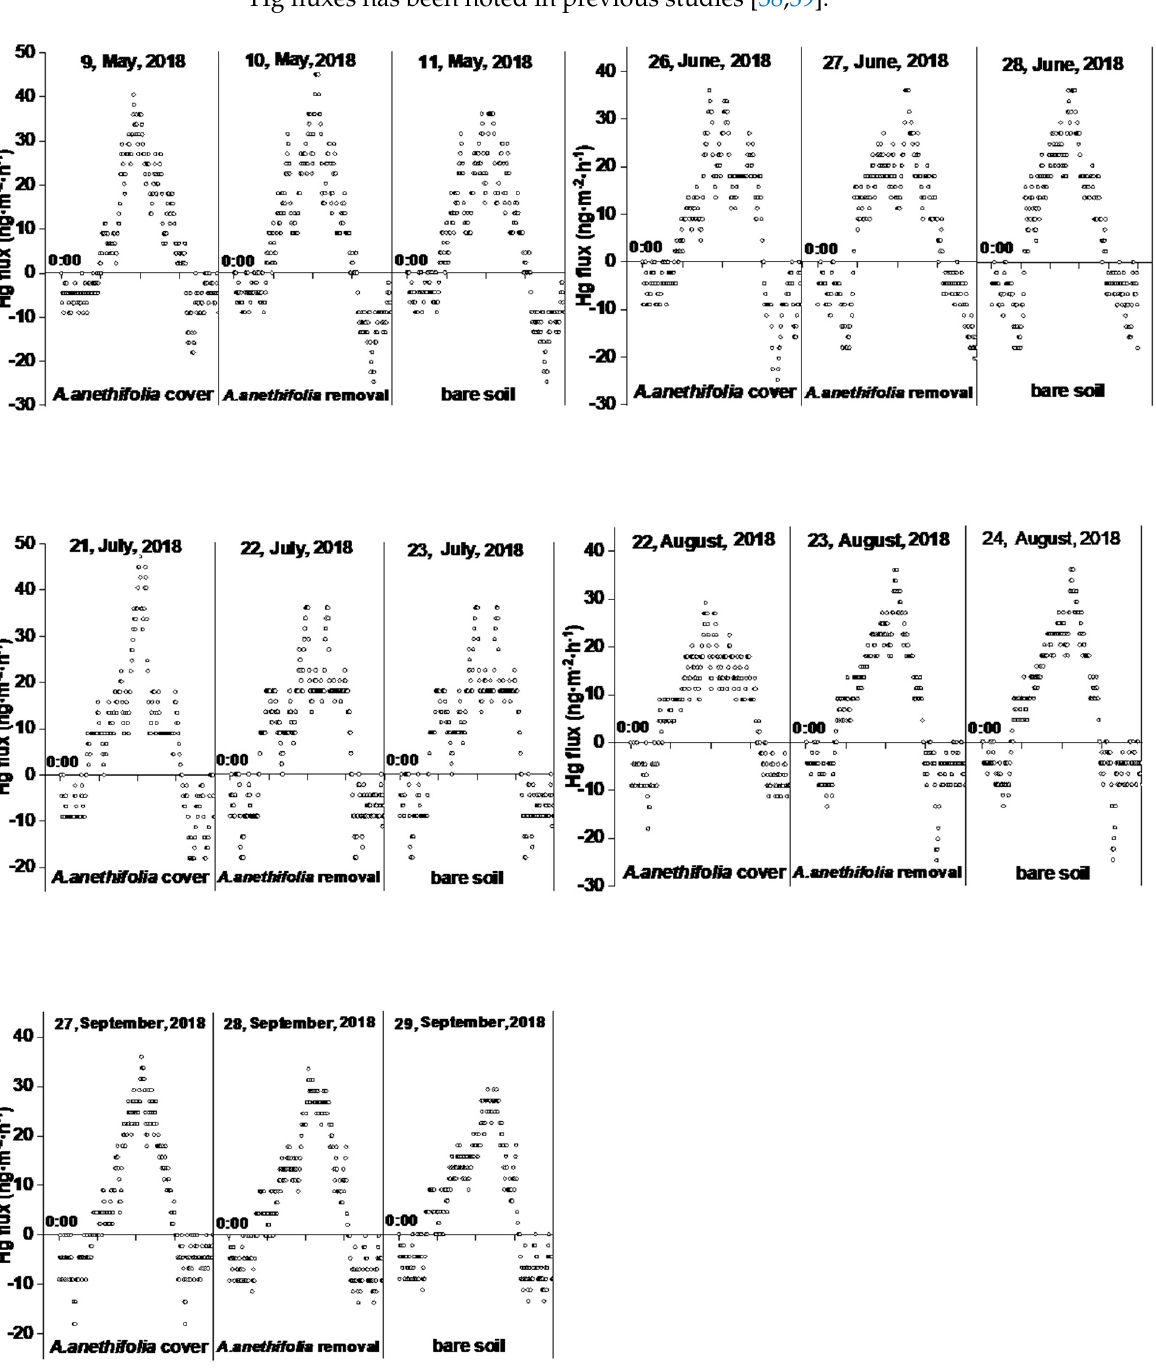
Figure 4. Diurnal variations of the Hg 0 flux (ng · m − 2 · h − 1 ) measurement data for the three conditions during each Figure 4 . Diurnal variations of the Hg 0 flux (ng·m − 2 ·h − 1 ) measurement data for the three conditions during each month.